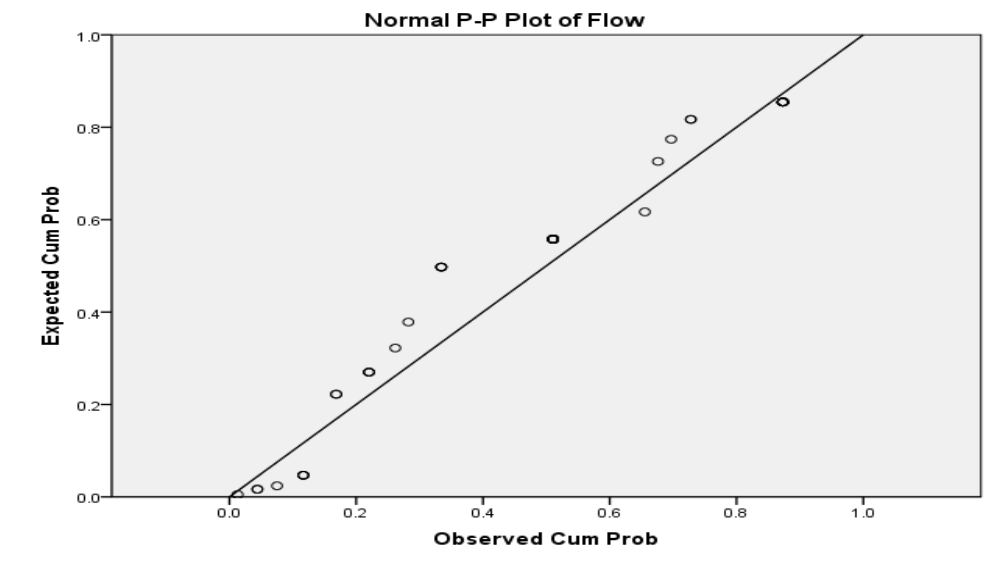
Figure 4. Lean Principles “Flow” against ISO 14001